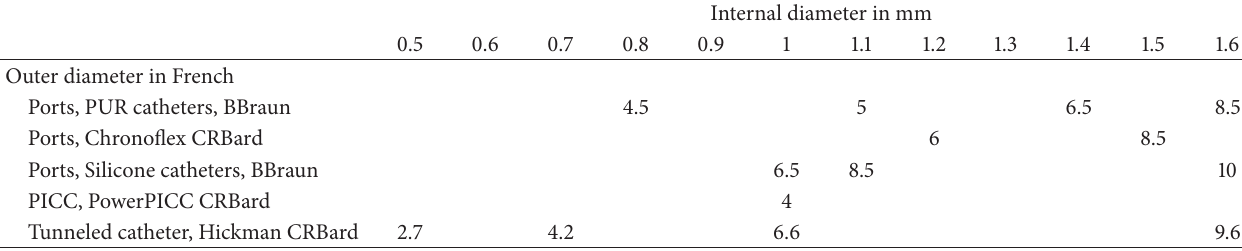
Table 3: Examples of corresponding internal and outer diameters in different types of single lumen catheters.